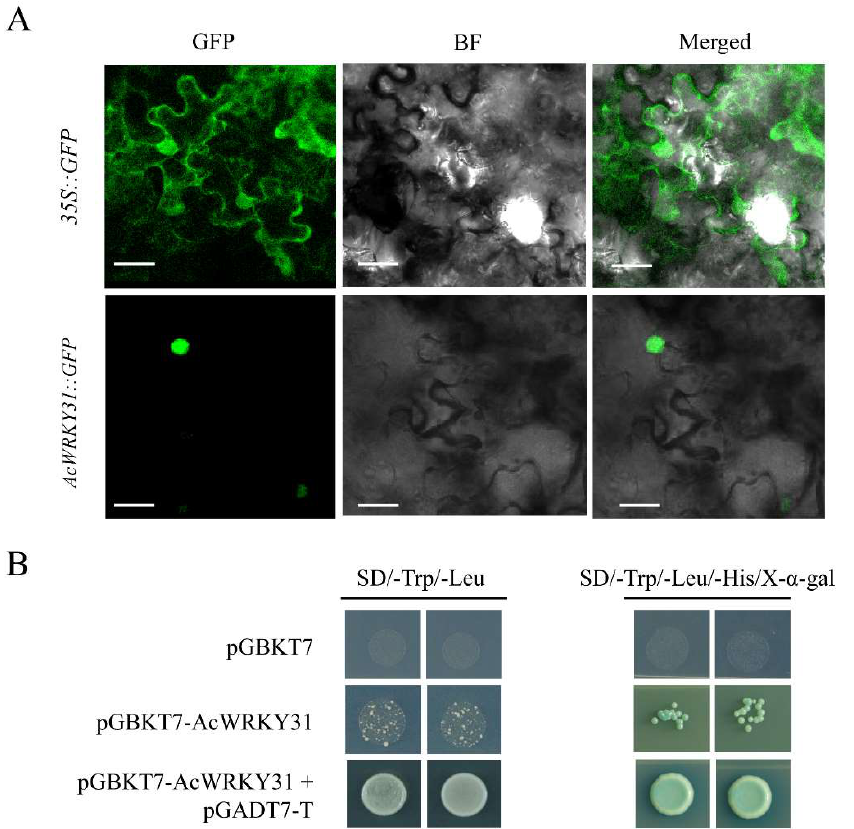
Figure 2. Subcellular localization and transcriptional activation analysis of AcWRKY31. ( A ) The fusion proteins 35S:: GFP and AcWRKY31::GFP were transiently expressed in in Nicotiana benthamiana leaves cells and observed with a laser scanning confocal microscope. Scale bar = 50 µ m. ( B ) Tran- scriptional activation analysis of AcWRKY31 .